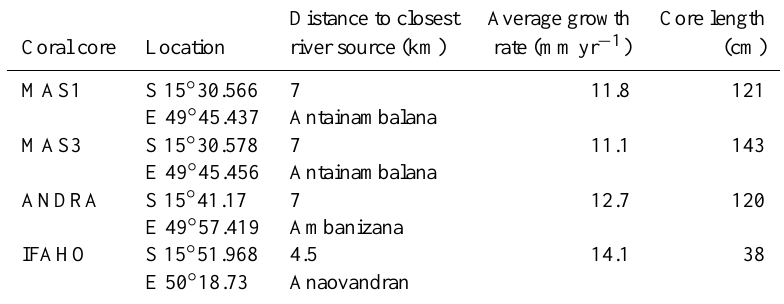
Table 1. Coral cores with GPS co-ordinates, growth rates, total core length, distance and name to the closest river source. Distance to closest Average growth Core length Coral core Location river source